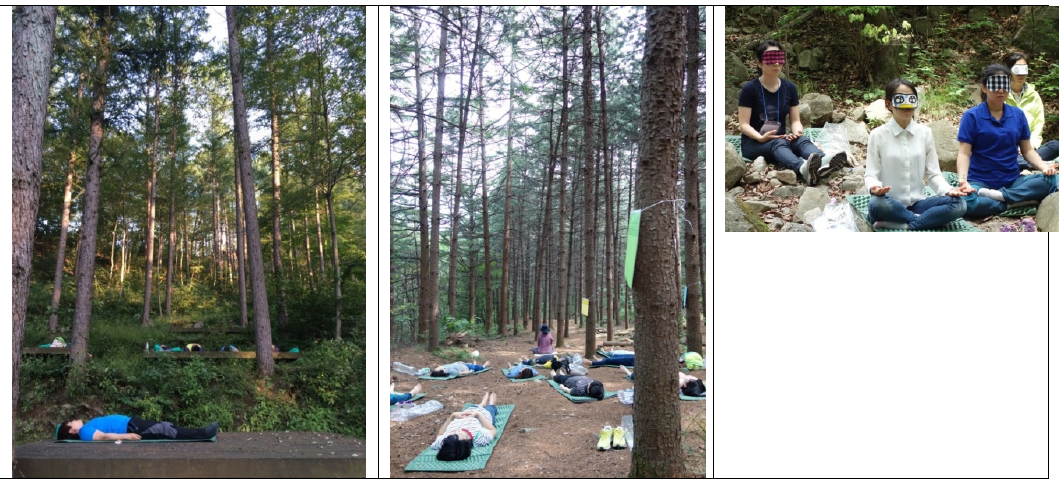
Figure 1. Impressions of therepeutic activities in the forest environment. Photographs courtesy of Haejung Kim. Haejung